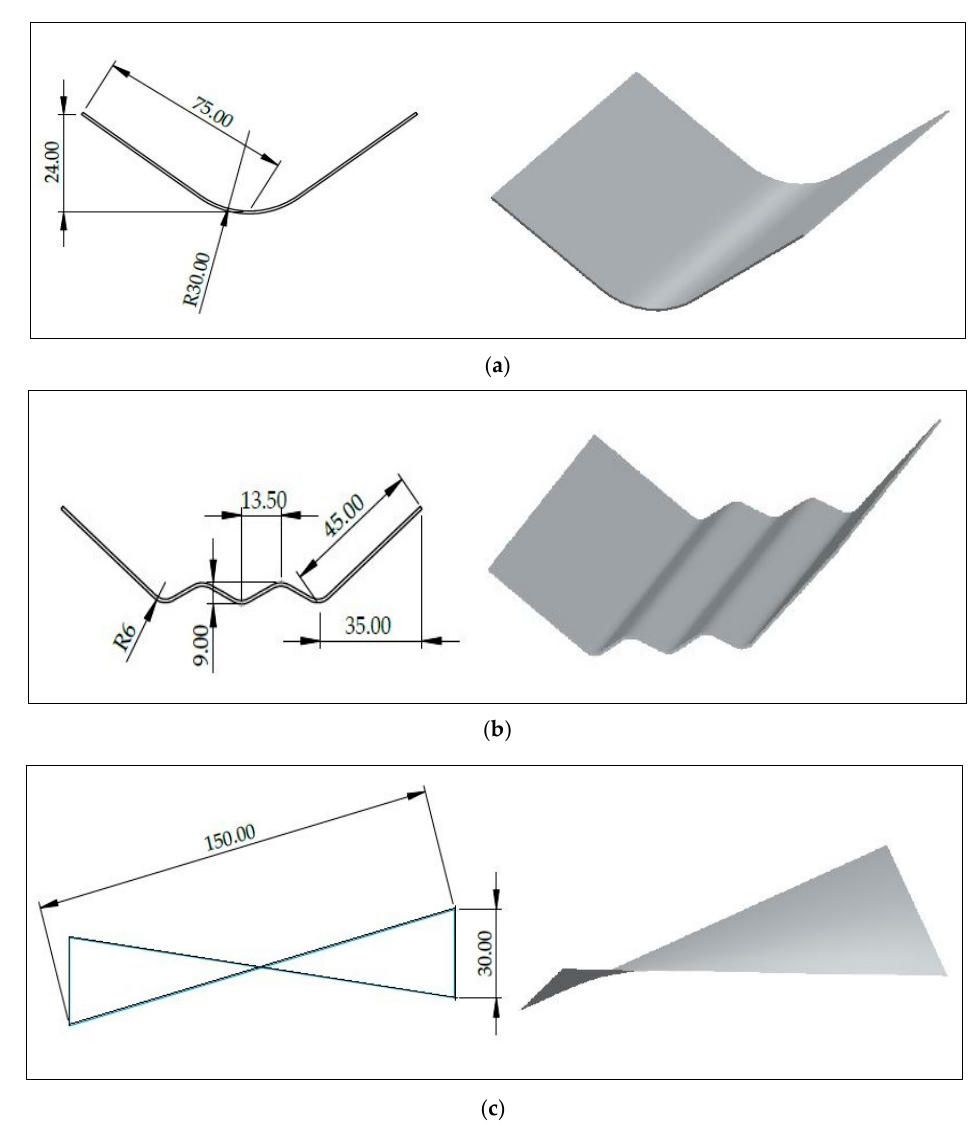
Figure 5. Geometry of Al1100 parts ( a ) form1; ( b ) form2; ( c ) form3. A Utest universal testing machine with a 20 kN maximum load capacity was used as the press source. The press head moved at a 1 mm/min stroke rate to form sheet metal at room temperature. SEA 40 oil was also utilized at the contact between the sheet and the pins for lubrication. In every 1 mm stroke, the load was acquired from the testing machine. The photos of the sheets during forming for forms1–3 are shown in Figure 6. The geometry of the forming areas of the die set was achieved by adjusting the pin height individually. Firstly, the forming area of the sheet metal was divided into 7 × 7 matrices, and then the necessary heights of pins were calculated from CAD data with Solidworks Premium 2018 ver. SP 0.0 software. ( a )